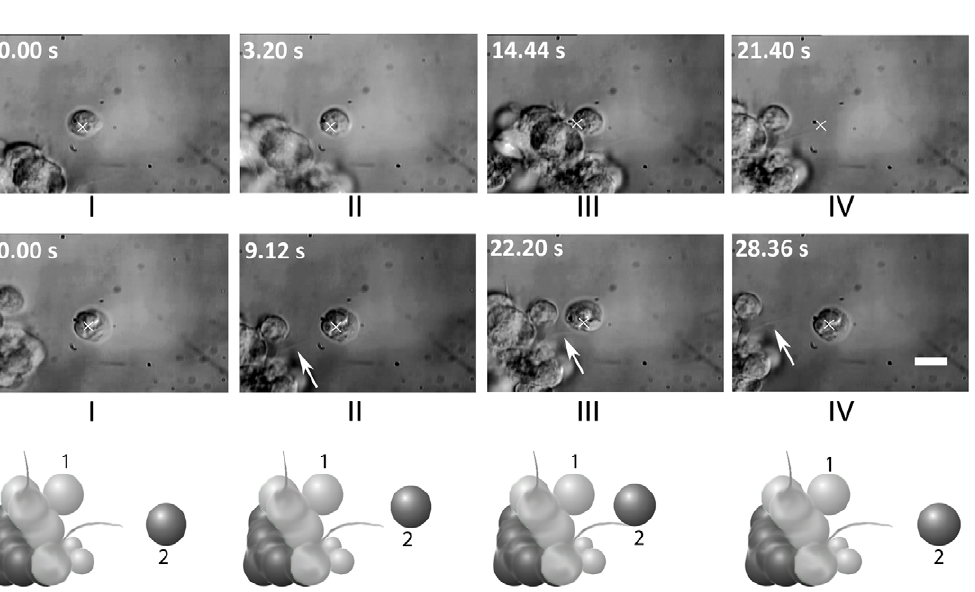
Figure 13. Differential effect of 0.1 m M Cytochalasin-D treatment on membrane and filopodial adhesion. A) Time-lapse images from a real-time movie (Movie S7) showing a cell (initially at the trap focus, X) approaching a neurosphere. As the trap is moved away (panel IV), the cell is seen to remain adhered to the neurosphere. B) Time-lapse images from a real-time movie (Movie S8) of a single cell approaching a filopodium on the neurosphere. Despite close proximity (for up to 7 seconds), no filopodial adhesion takes place: the cell remains within the trap focal volume, X, as it is moved away from the neurosphere. The cartoon below panel B is a chimera depicting both phenomena (as cells numbered 1 and 2, respectively). The scale bar denotes 10 m m.